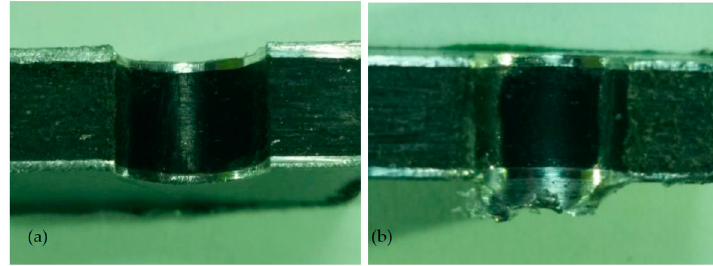
Figure 8. The cross-section of the sandwich material drilled, ( a ) without a burr and ( b ) with a burr.